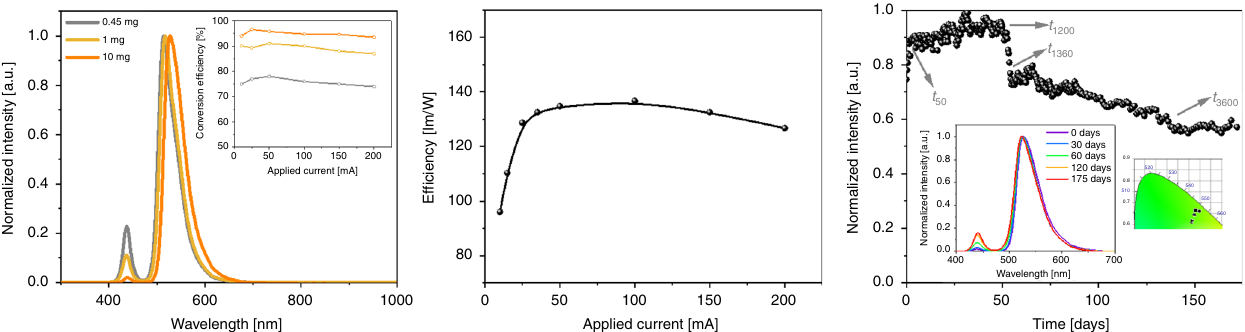
Fig. 5 Bio-HLED stability studies. Left: emission of Bio-HLEDs with biophosphors containing different amounts of eGFP-AA at a driving current of 30 mA. The inset graphs display the changes in the conversion ef fi ciency values upon increasing the applied current. Center: changes in the device ef fi ciency upon increasing the applied current. Right: changes in the intensity of the biophosphor emission over time in Bio-HLEDs driven at 30 mA. The inset shows the changes in the overall electroluminescence spectra (left) and its x / y CIE color coordinates (right) of Bio-HLEDs